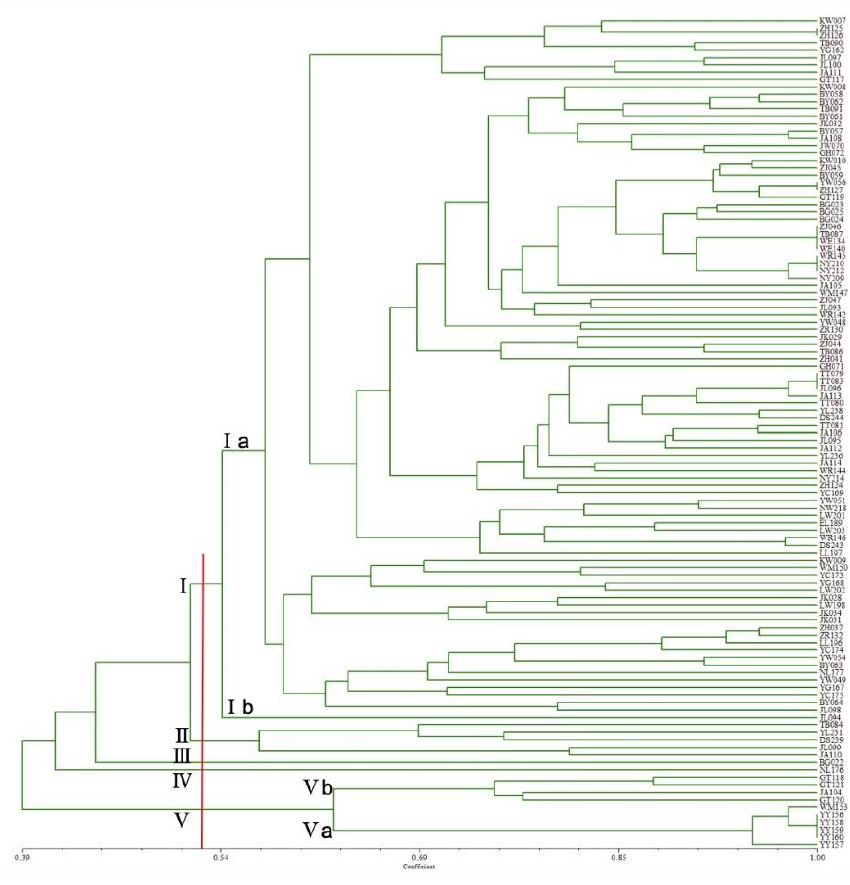
Figure 2. UPGMA dendrogram of 112 Tartary buckwheat landraces accessions based on genetic similarity. (I, II, III, IV, and V represents five different clusters, and a and b represent a subclass.) 3.3. Genetic Diversity of Tartary Buckwheat’s 29 Populations (Villages) Based on SSR Analysis The results of the genetic diversity of Tartary buckwheat populations are shown in Table S3. The means of observed alleles ( Na ) and effective alleles ( Ne ) were 1.738 (ranging from 1.083 to 2.500 for JW/WE and JA) and 1.535 (ranging from 1.083 to 2.082 for